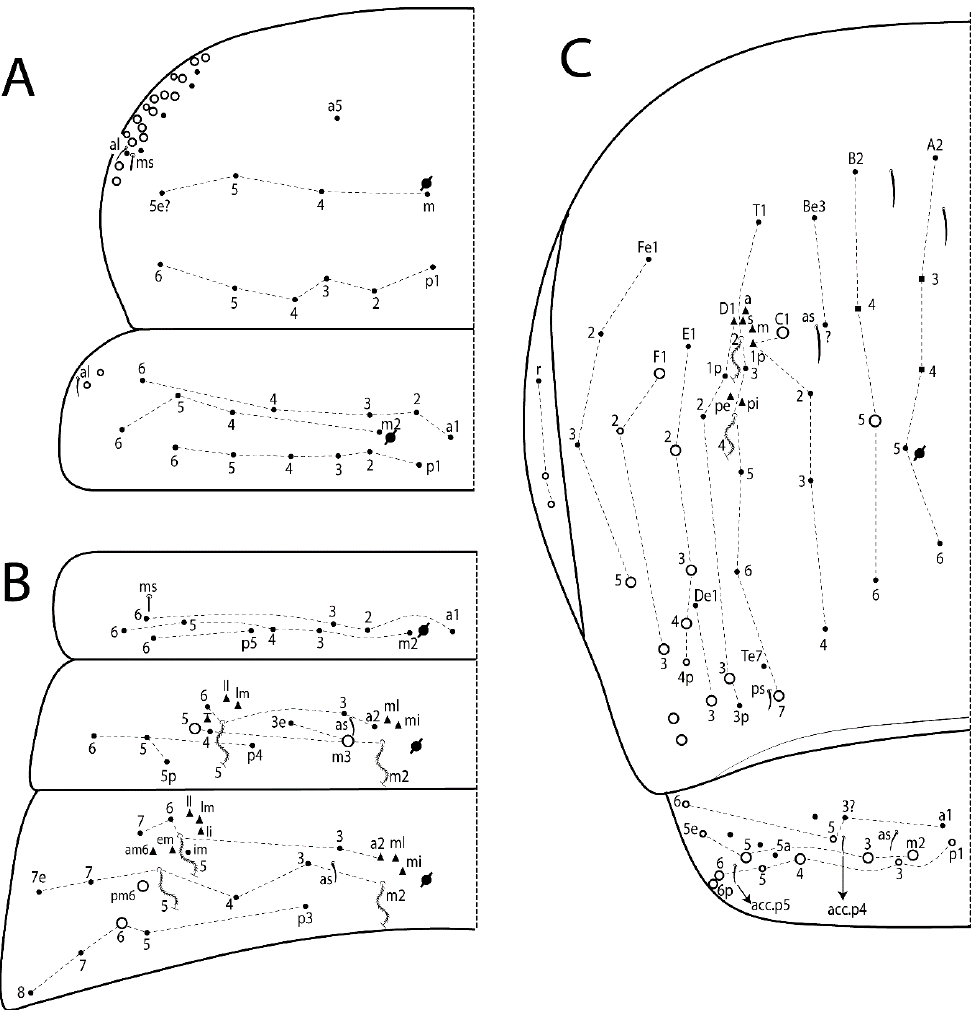
Figure 26. Pseudosinella paraensis sp. nov.: dorsal chaetotaxy. ( A ) Th II–III; ( B ) Abd I–III; ( C ) Abd IV– V.